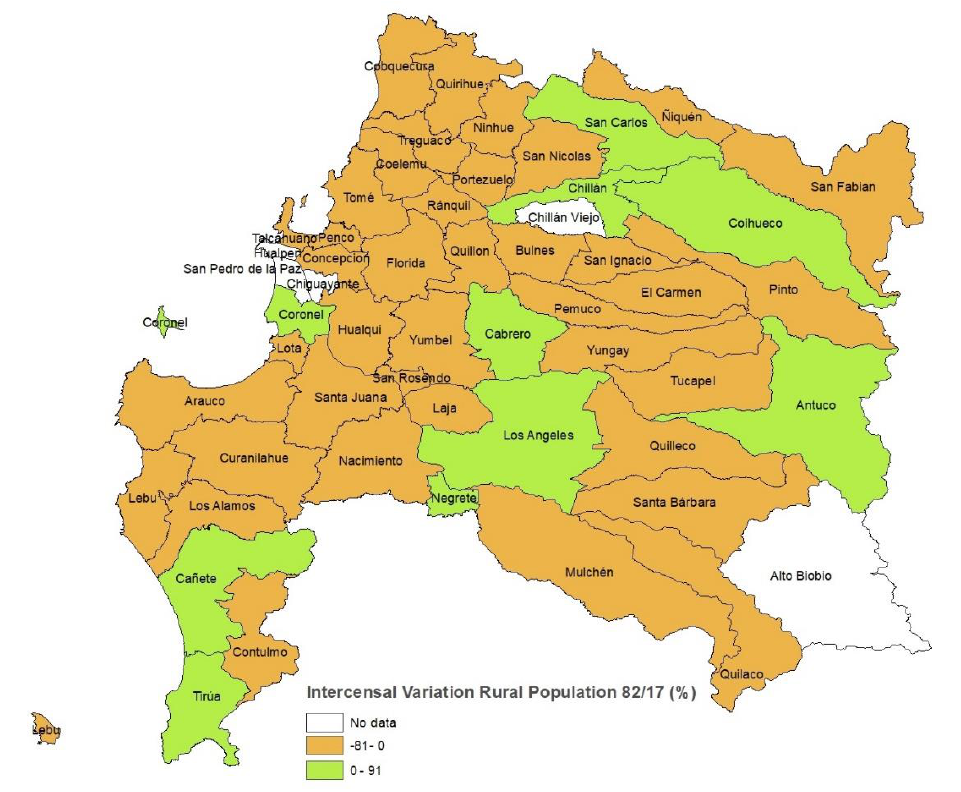
Figure 7. Variation (%) in rural population between the Censuses of 1982 and 2017.